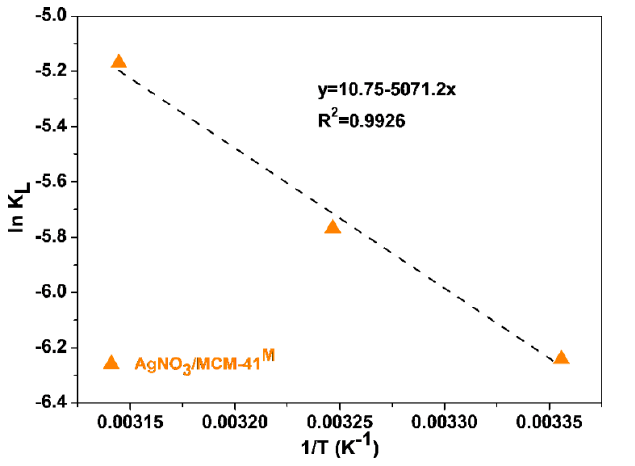
Figure 9. Van’t Ho ff Figure 9. Van’t Hoff plot.